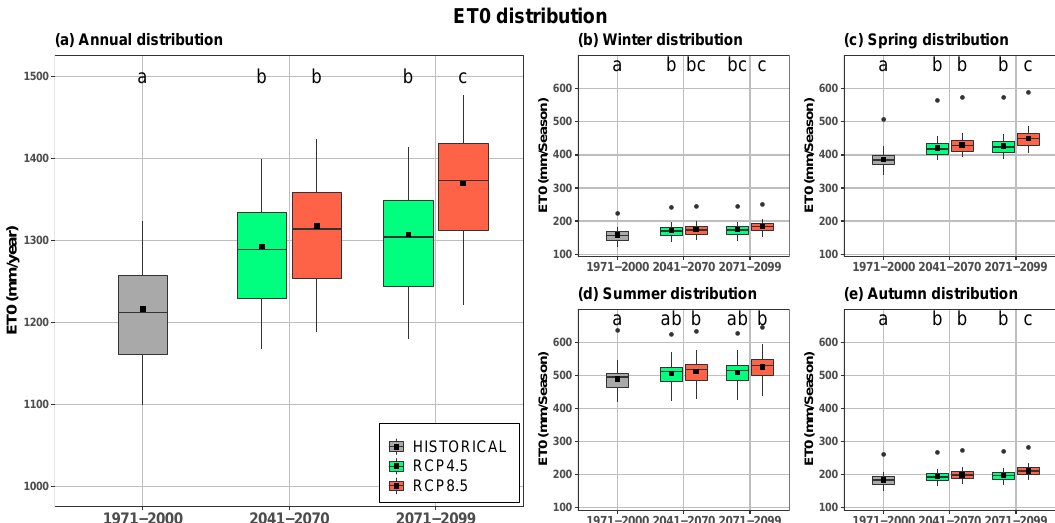
Figure 7. Distributions of ( a ) mean total annual ET 0 and ( b – e ) mean total seasonal ET 0 obtained for the time intervals ( x axis) considered in each climate change scenario (box classes). The values associated to each weather station are represented in the boxes ( N = 48 stations per box). Significantly different groups (Tukey–Kramer contrast, alpha = 0.05) are represented by different